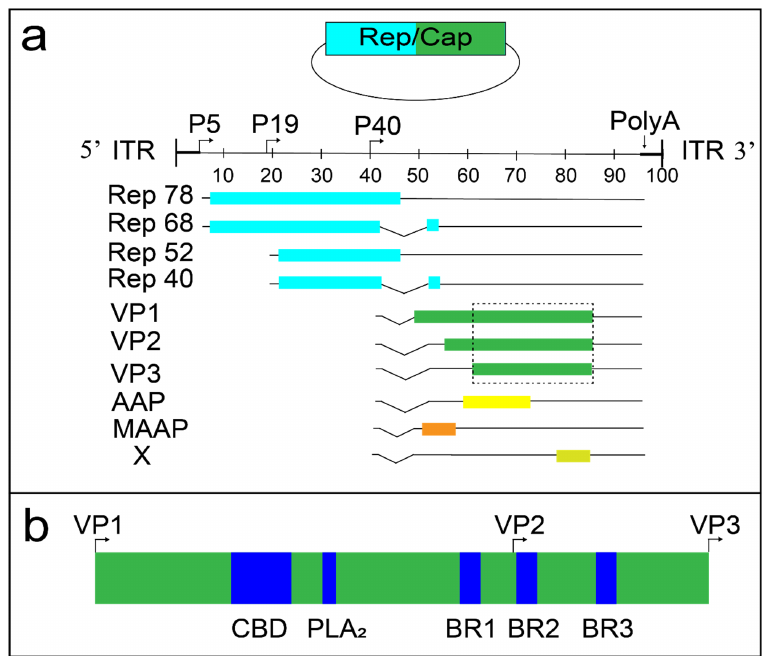
Figure 1. The AAV2 genome and VP1/2 region. ( a ) Rep/Cap plasmids (top of panel) encode multiple proteins (light blue = Rep; green = Cap). The linear ssDNA wtAAV2 genome is flanked by inverted terminal repeats (ITRs). Four Rep proteins are produced in the 5 ′ coding region (left side = light blue). VP1-3, AAP, MAAP, and X proteins are expressed in the 3 ′ region (right side = green). The dashed line rectangle surrounds the VP3 common region of VP1-3, which produces known native AAV structures (Table 1). ( b ) The VP1/2 region contains basic regions 1-3 (BR1-3), a phospholipase A 2 (PLA 2 ) en- zyme and a calcium binding domain (CBD). In addition to VP1-3, the ~2.2 kb cap region encodes at least three known alternate reading frames (i.e., overprinted regions; Figure 1a). The 5 ′ region of the AAV2 cap coding region contains the recently discovered 119 amino acid MAAP protein [38] and the AAP protein (204 aa) [42–47]. The X gene encodes a protein of 172 amino acids at the 3 ′ end of